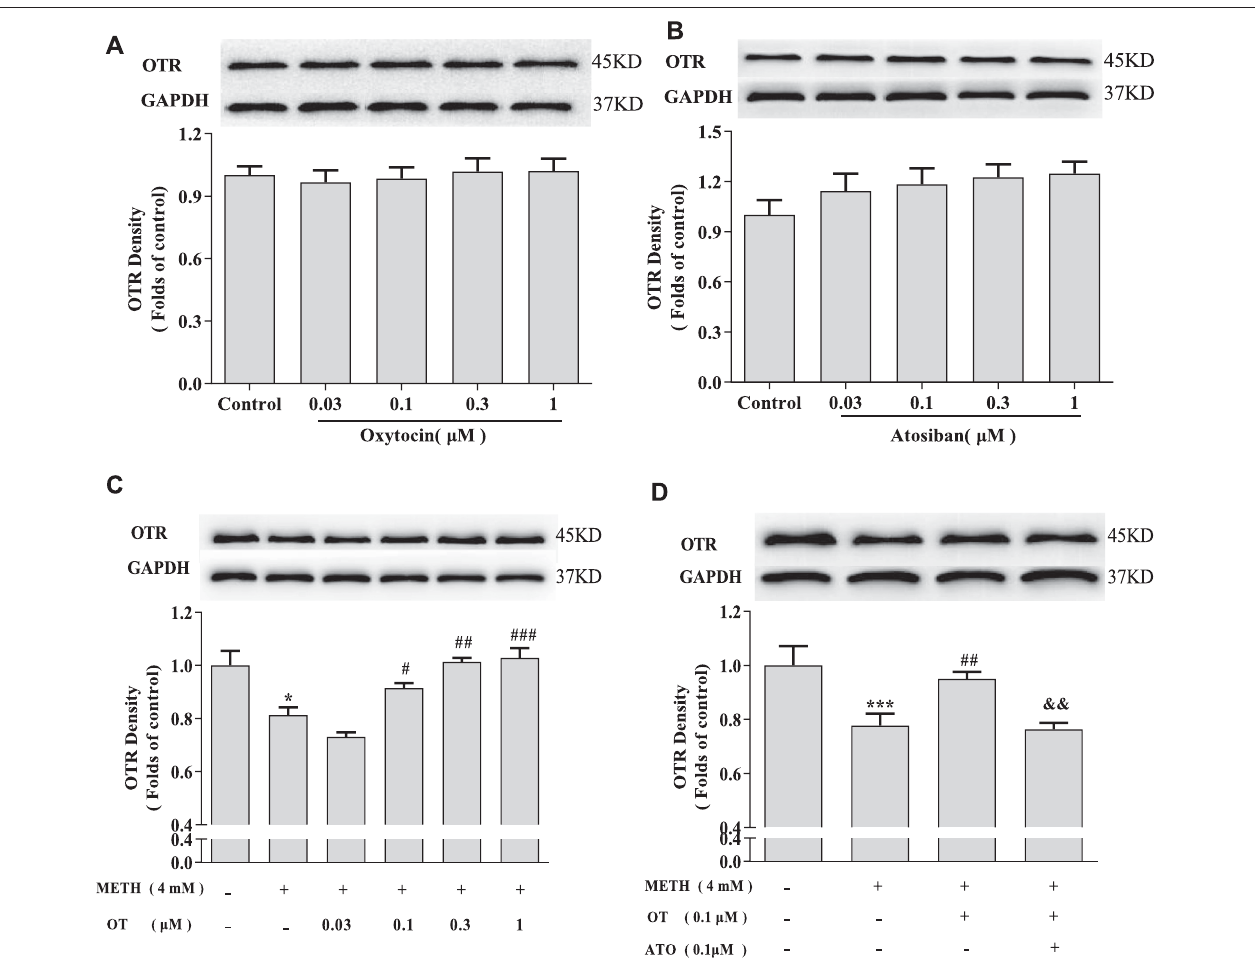
FIGURE5| EffectsofOTand ATOon theexpression ofoxytocinreceptor changed byMETHinthe hippocampal neurons. (A) Hippocampal neurons weretreated with OT (0.03 – 1 μ M) for 24 h. (B) Hippocampal neurons were treated with ATO (0.03 – 1 μ M) for 24 h. (C) Hippocampal neurons were pre-treated with OT (0.03 – 1 μ M) for 2 h and stimulated with METH (4 mM) for 24 h by western blotting. (D) Hippocampal neurons were pre-treated with OT (0.1 μ M) and ATO (0.1 μ M) for 2 h and stimulatedwithMETH(4 mM)for24 hbywesternblotting.Thedatawereshownasmean ± SEM( n (cid:2) 3).* p < 0.05,*** p < 0.001comparedwithcontrolgroups; # p < 0.05, ## p < 0.01, ### p < 0.001 compared with METH groups; && p < 0.01 compared with METH + OT groups. Oxytocin Attenuates the Decrease of Phospho-CREB Expression Induced by Methamphetamine Through Oxytocin Receptor in Hippocampal